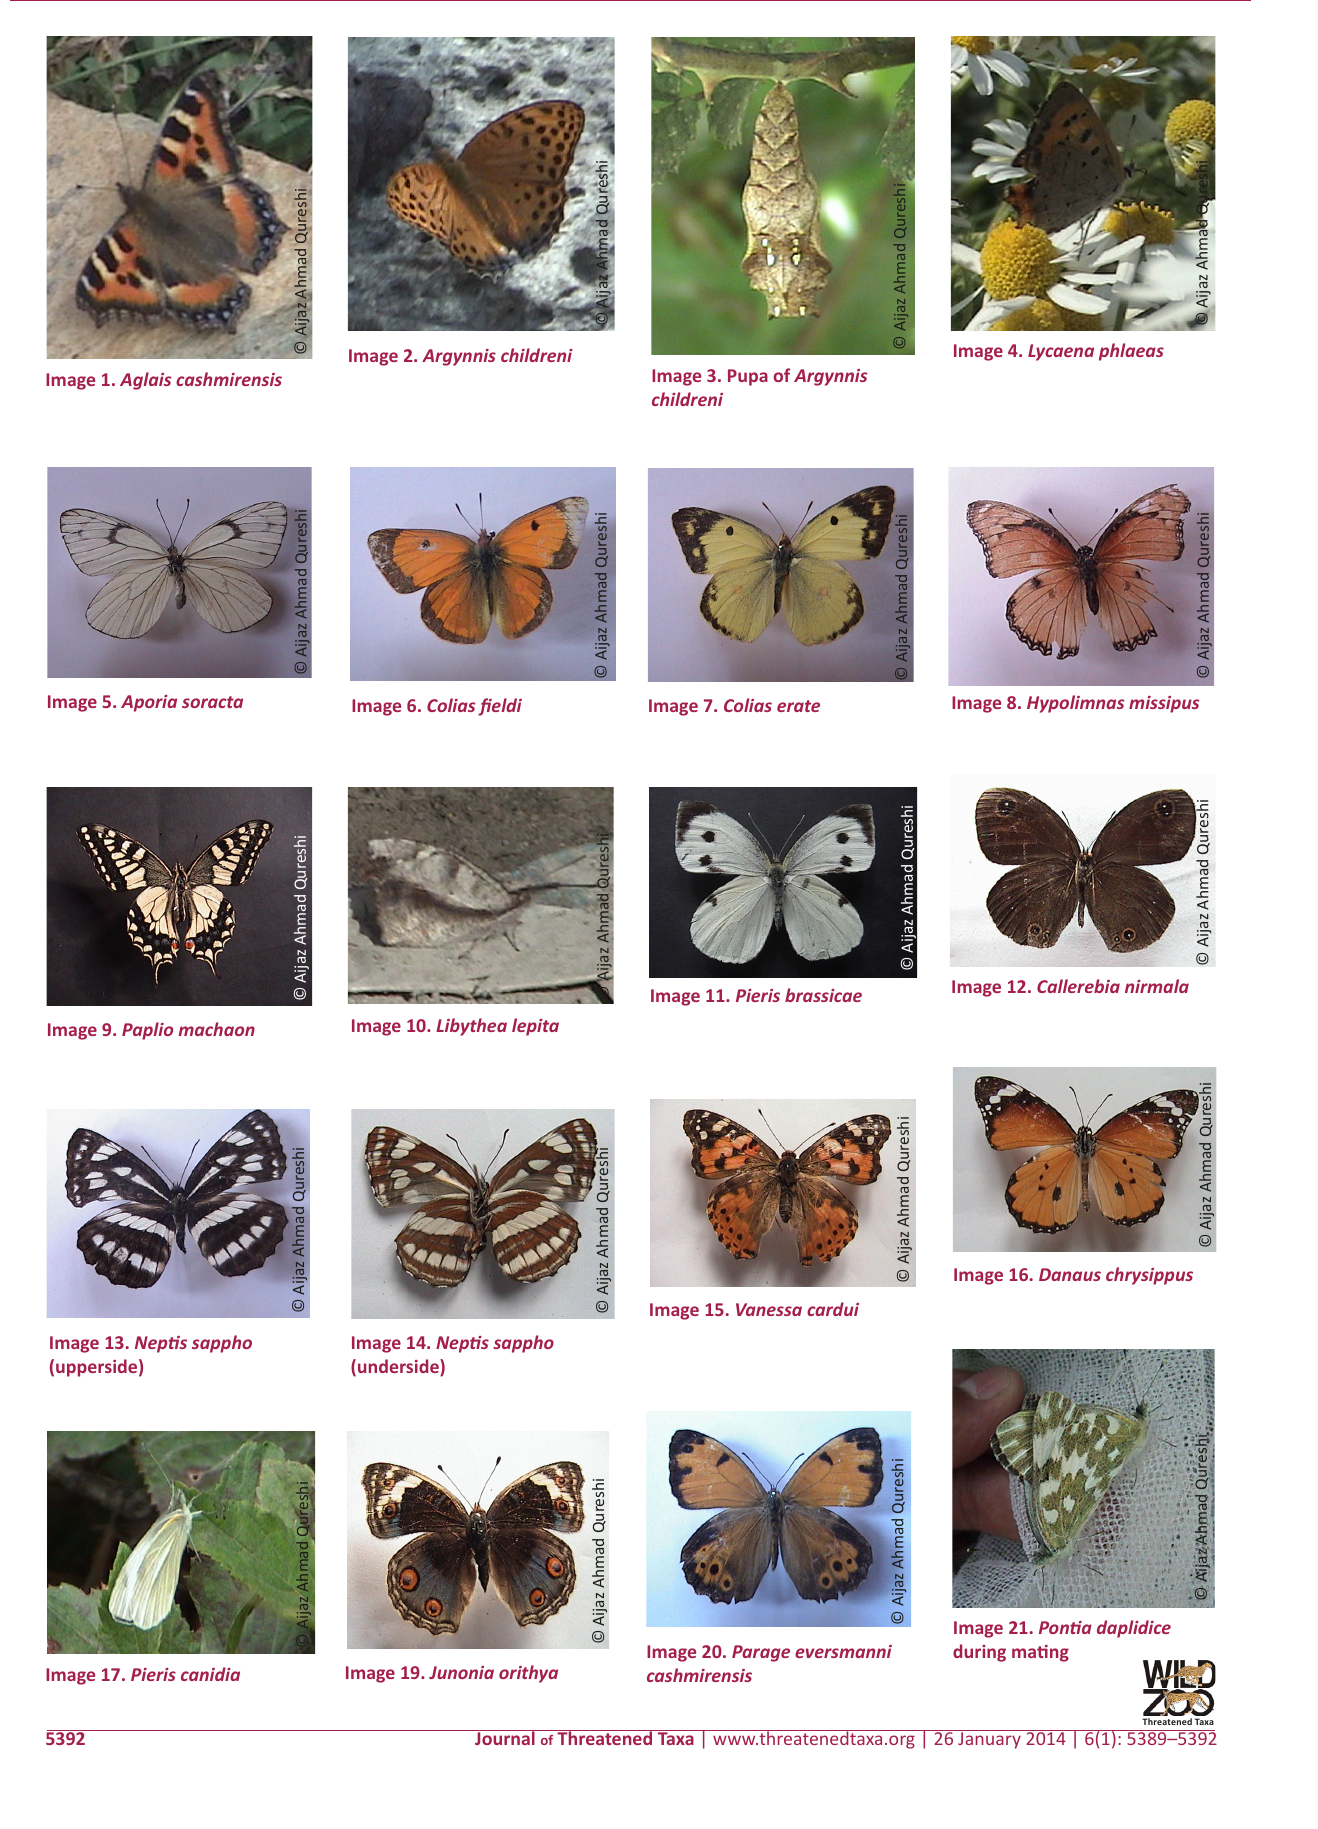
Image 19. Junonia orithya